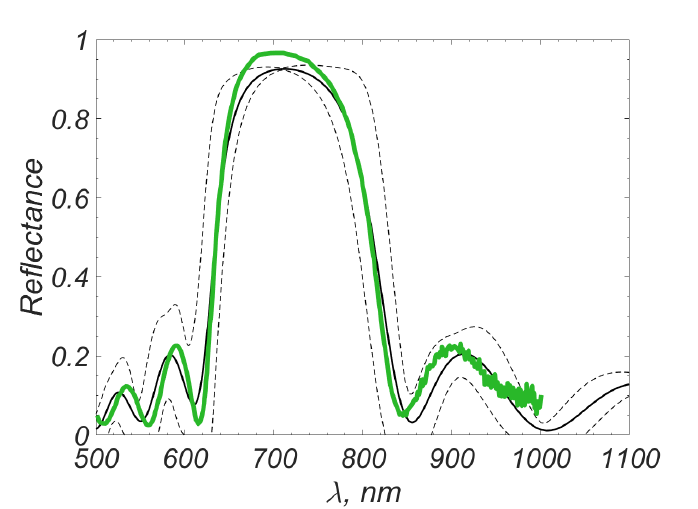
Figure 14. Photonic crystal from Figure 8. Reflection spectrum for the s -polarized wave. The notations correspond to Figure